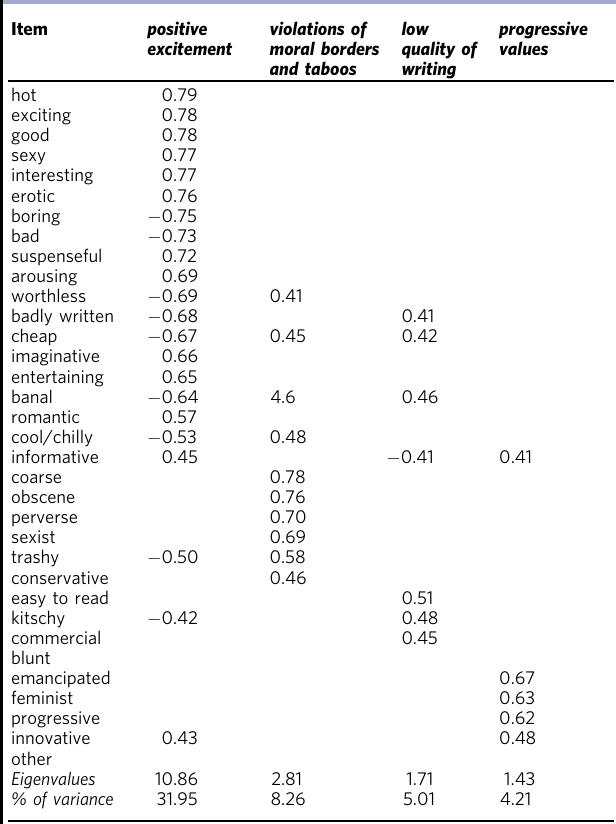
explaining 52% of the variance of the initial item set. Table 3 shows the factor loading after rotation.